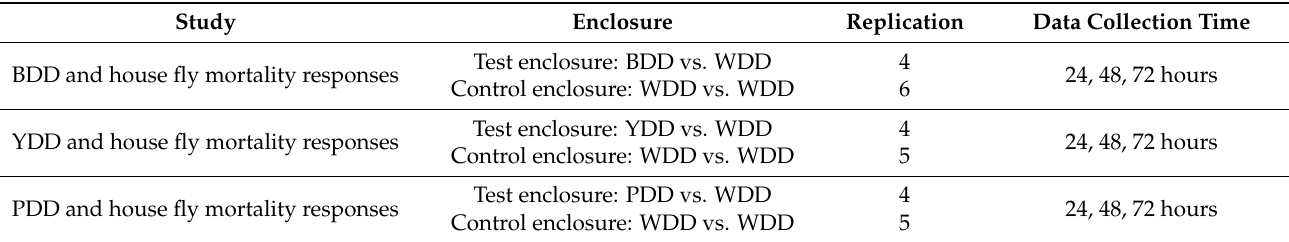
Table 1. Experimental setups.